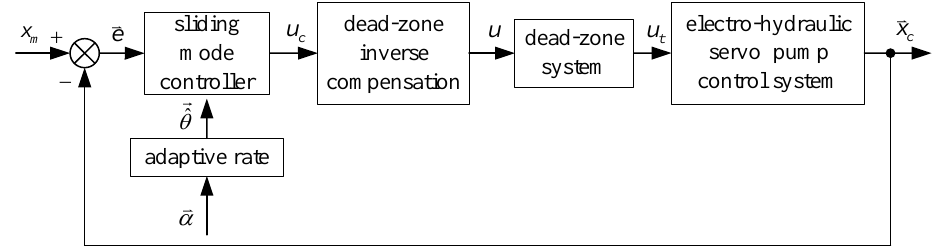
Figure 4. Series control block diagram of pump control system.